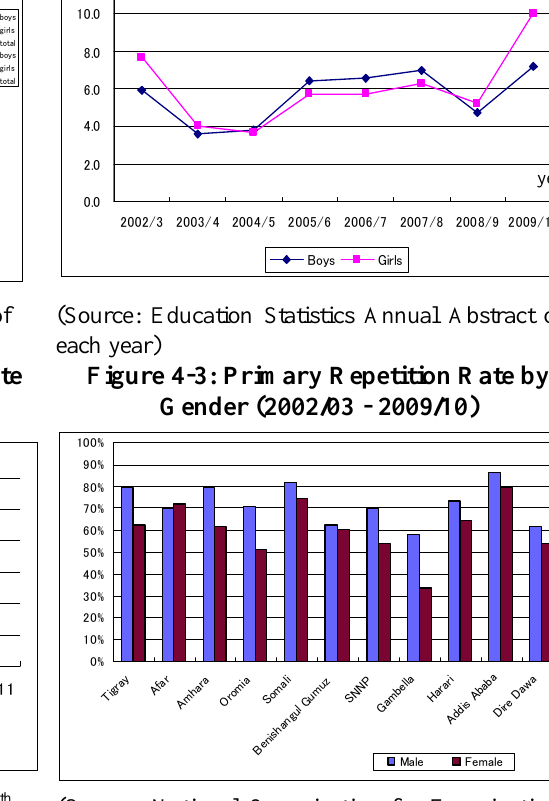
Figure 4-4: Primary Completion Rate Figure 4-5: Percentage of Pupils who Passed the General Secondary Education Certificate Examination